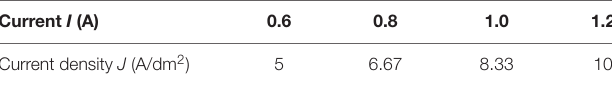
TABLE 2 | The conversion relationship between current and current